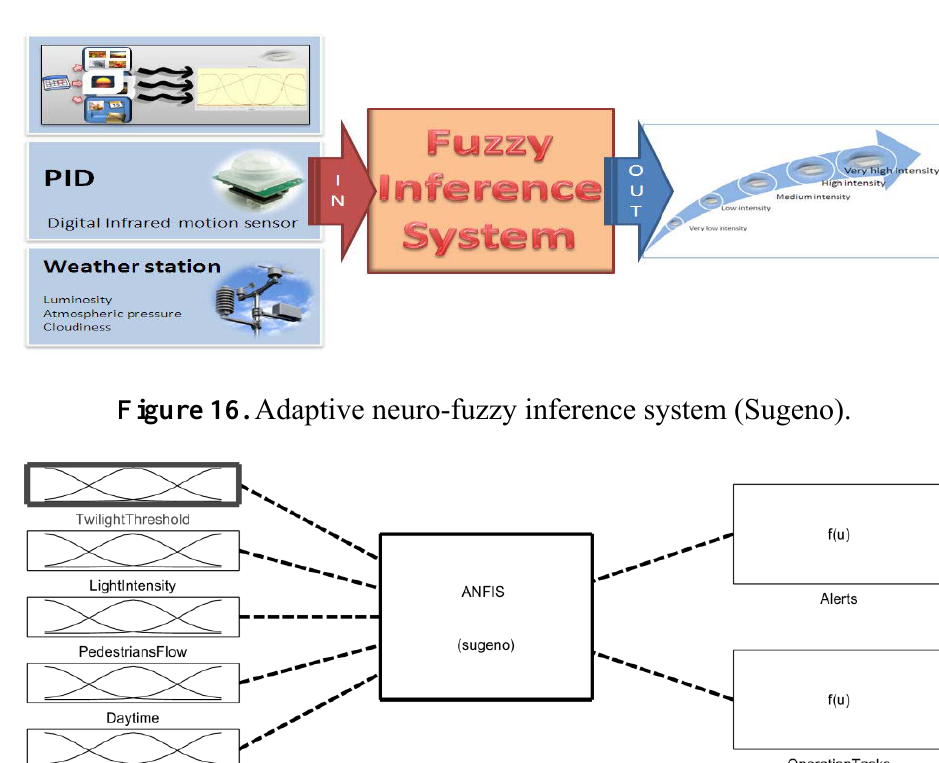
Figure 15. Information fusion by the embedded fuzzy interference system.